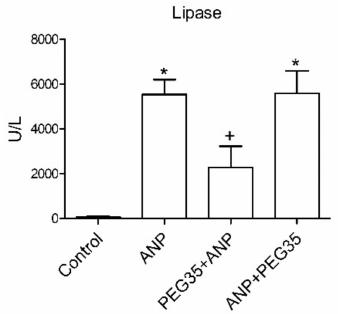
Figure 1. E ff ect of PEG35 treatment on plasma lipase activity in sodium taurocholate-induced ANP. Plasma lipase levels in U / L. Bars represent mean values of each group ± SEM. * p < 0.05 versus Control, + p < 0.05 versus ANP. ANP, Acute Necrotizing Pancreatitis. PEG35, Polyethylene glycol 35. Each determination was carried out in